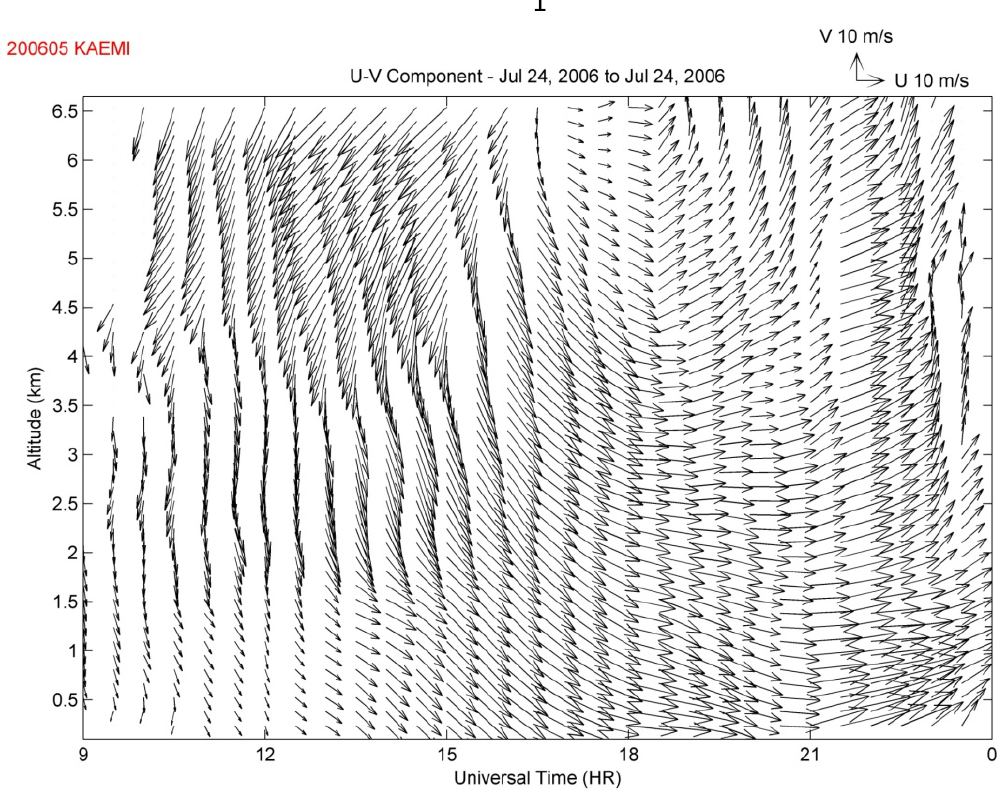
Fig. 2. Altitude-time profile of the Horizontal wind observed during the passage of Typhoon Kaemi.